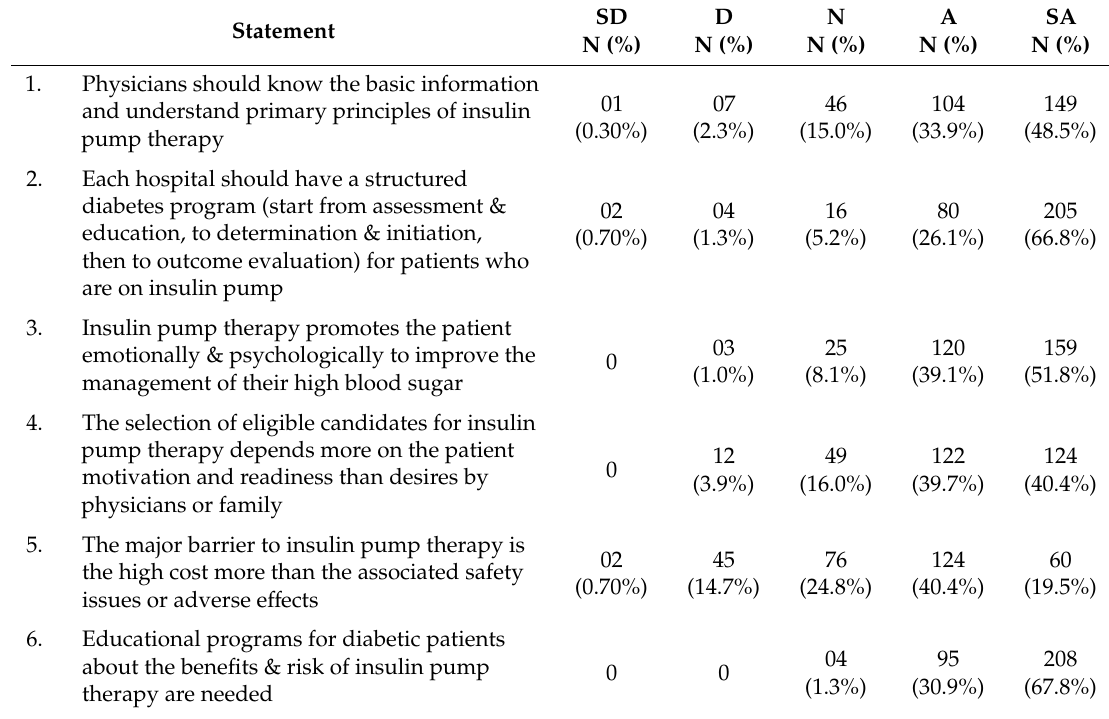
Table 3. Assessment of the attitude toward insulin pump therapy (n =